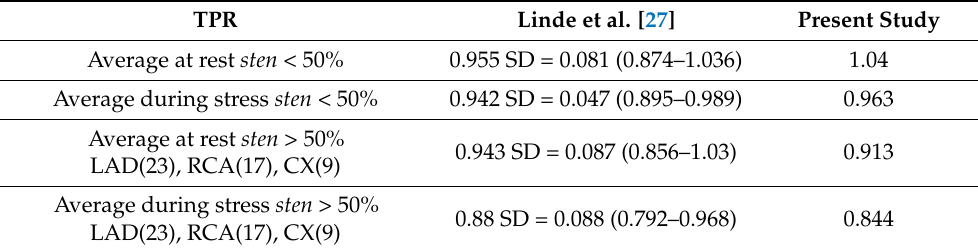
Table 1. Comparison between average TPR estimated by Linde et al. [27] and by the present study. SD stands for standard deviation. The numbers in parenthesis indicate the corresponding ranges.